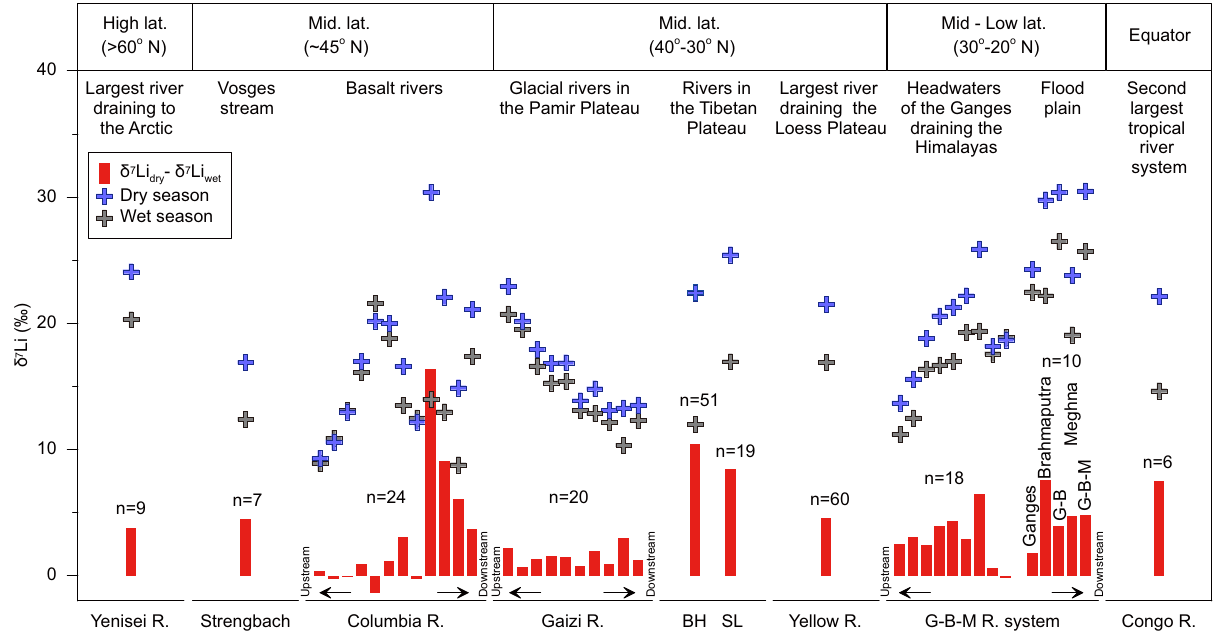
Fig. 2 Seasonal differences in river water δ 7 Li across latitudes. Mainstreams and tributaries in river basins from ~1 to >10 6 km 2 in drainage area show systematically higher δ 7 Li values in dry seasons ( δ 7 Li dry , blue crosses) than those in wet seasons ( δ 7 Li wet , grey crosses). For time-series data (weekly or monthly samples at one sampling site) in the BH and SL (Fig. 1, this study), Yenisei 48 , Strengbach 10 , Yellow 47 , and Congo 37 (Supplementary Fig. 6), the highest values in dry seasons and lowest in wet seasons are presented to explore their maximum differences (Red bars, de fi ned as: δ 7 Li dry − δ 7 Li wet ). For other seasonal data, the Columbia 38 , Gaizi (this study), and Ganges-Brahmaputra-Meghna River (G-B-M R.) systems 8,39 show spatial spot samples from upstream to downstream in each basin, with samples collected both in dry and wet seasons for each sample site (Supplementary Fig. 5). Red bars represent their seasonal differences by sample sites. In the Gaizi River, seasonal data are distributed from glacier margins to downstream. In the G-B-M R. system, seasonal data are presented from the small headwater of the Ganges 8 to large main tributaries (Ganges, Brahmaputra, Meghna) and further to downstream mainstem (G-B-M) 39 . “ n ” is the number of the data collected for each basin. See Supplementary Note 1 and Data 1 for additional details and data sources. Errors for δ 7 Li are similar to the symbol size.